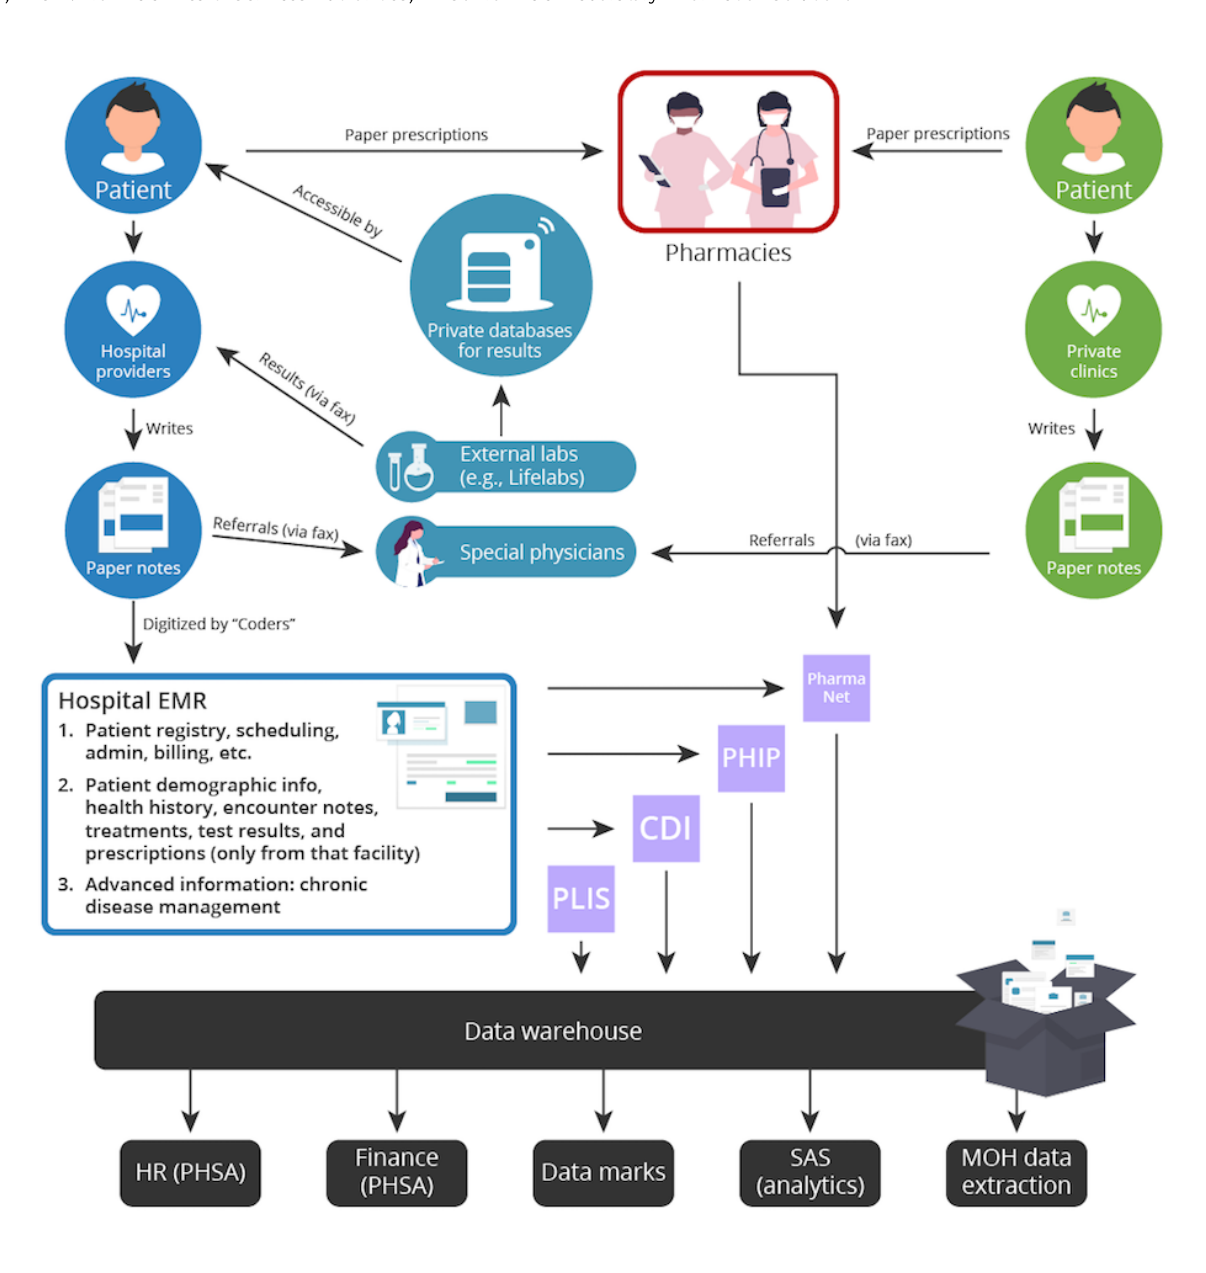
Figure 1. Flow of health care data in British Columbia Provincial Health Services Authority. CDI: Clinical Diagnostic Imaging; EMR: electronic medical record; HR (PHSA): Human Resources (Provincial Health Services Authority); MOH: Ministry of Health; PHIP: Public Health Improvement Plan; PHSA: Provincial Health Services Authorities; PLIS: Provincial Laboratory Information